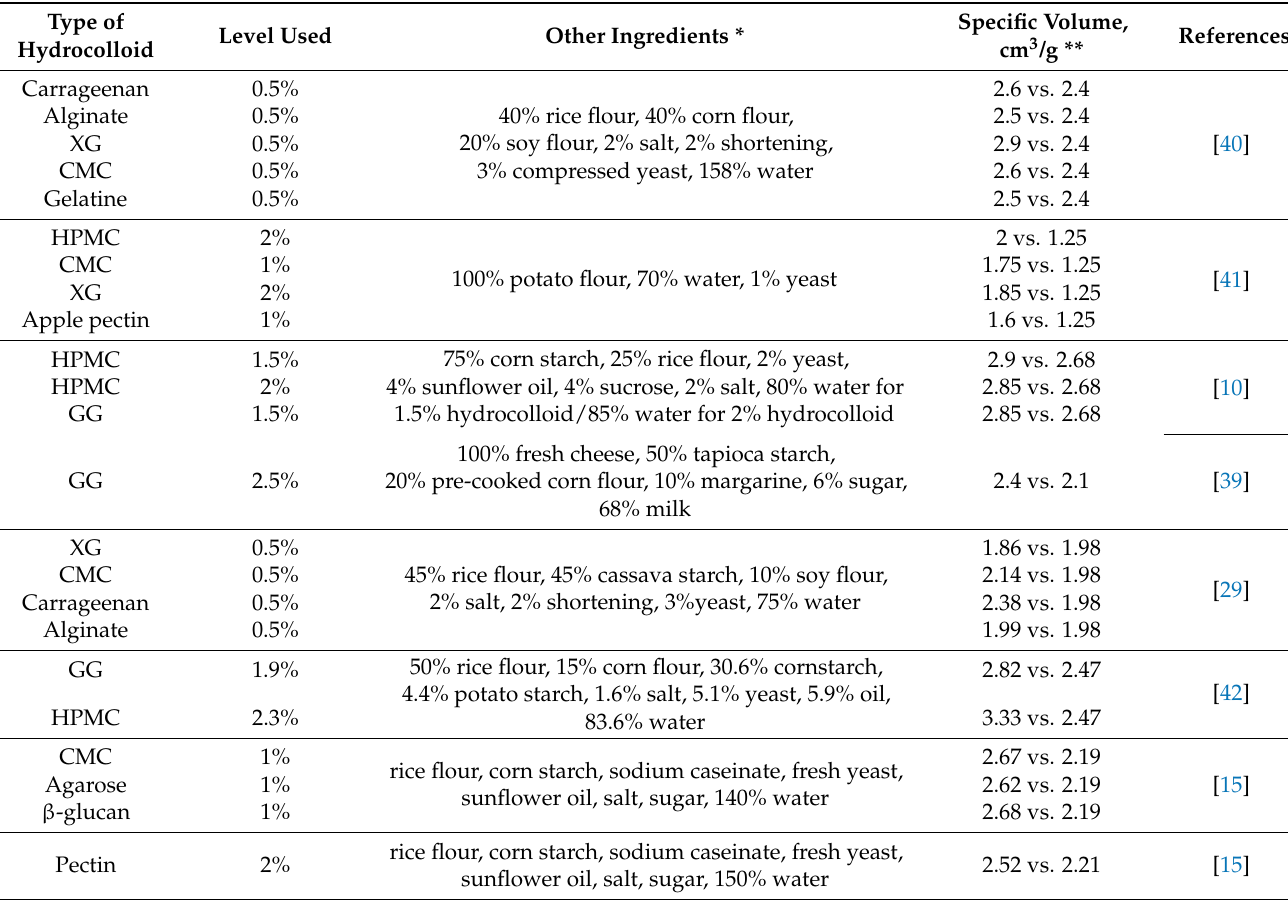
Table 3. Effect of hydrocolloids on the bread specific volume as compared to